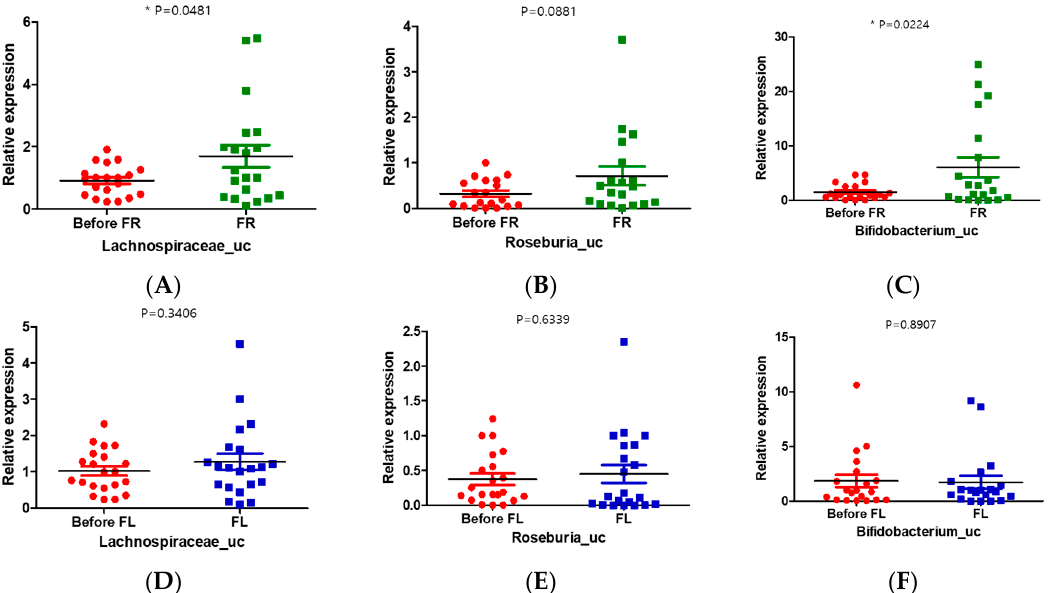
Figure 5. Quantitative changes in the gut microbiome in the before and after treatment (FR or FL) group. ( A , D ) Unclassified Lachnospiraceae ( Lachnospiraceae_uc ); ( B , E ) unclassified Roseburia ( Roseburia_uc ); ( C , F ) unclassified Bifidobacterium ( Bifidobacterium_uc ) in the FR (green) or FL (blue) groups. * p < 0.05.